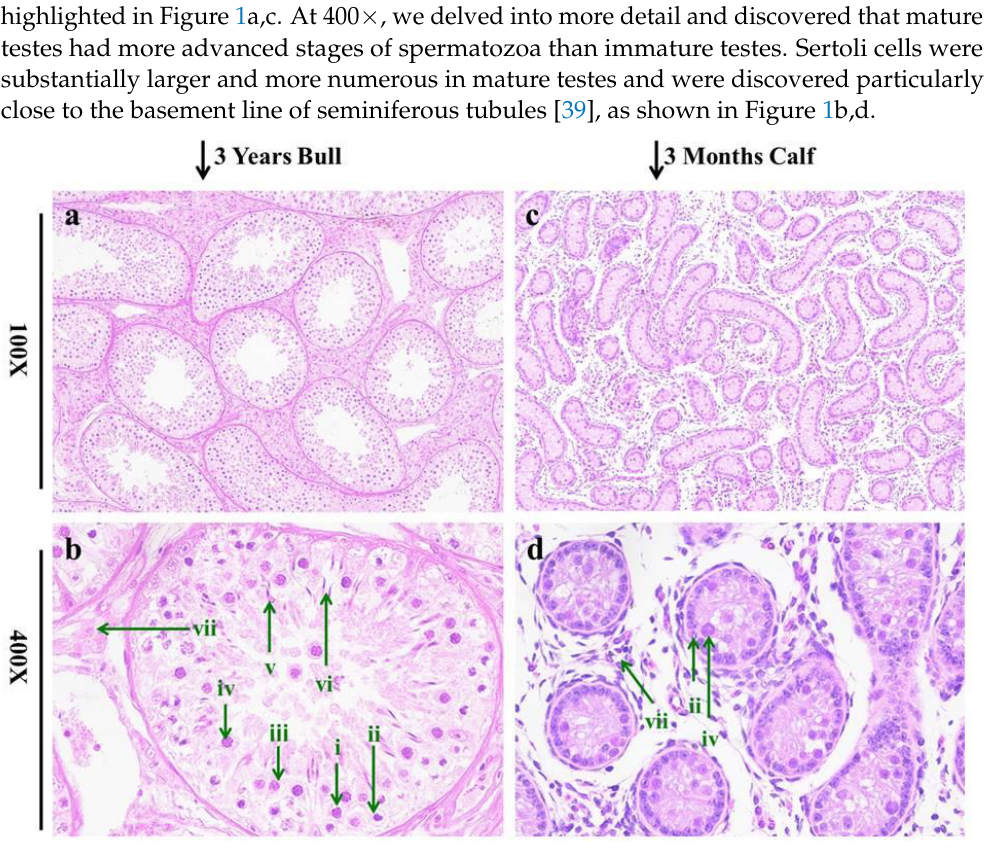
Figure 1. The histomorphology of bull and calf testicular tissues were studied under a microscope at 100× and 400× magnifications. Sections ( a , b ) characterize the morphology of 3-year-old bull testes, whereas sections ( c , d ) indicate the morphology of 3-month-old calf testes. The green arrows show the biogenesis of germ cells. i: spermatogonia, ii: Sertoli cells, iii: spermatocytes, iv: round spermatids, v: elongated spermatids, vi: mature spermatozoa. vii: Leydig cells.